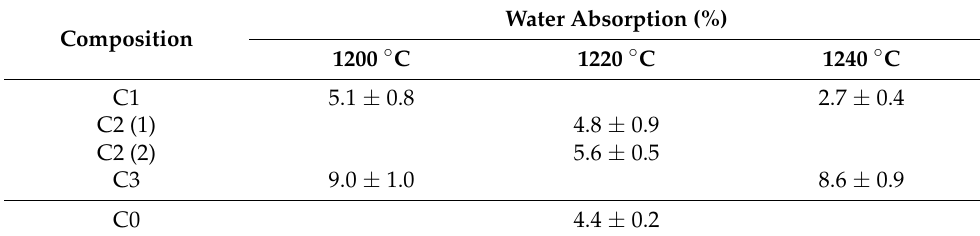
Table 9. Water absorption of studied compositions at different firing temperatures.